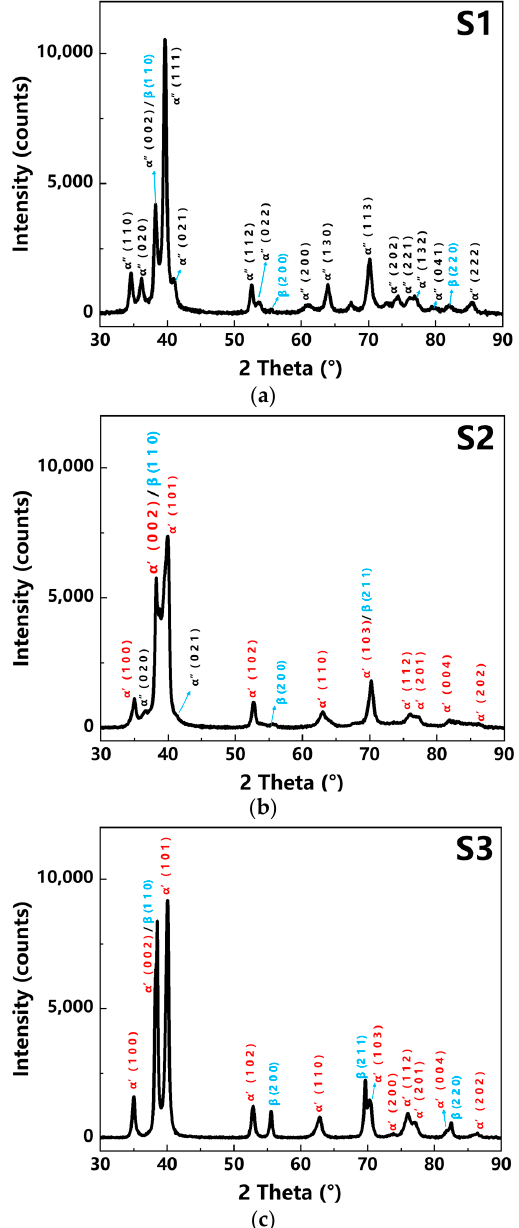
Figure 8. XRD pattern of LPBF Ti ‐ Ta for different volume energy density conditions. ( a ) S1 (v = 120 mm/s, E = 694 J/mm 3 ), ( b ) S2 (v = 220 mm/s, E = 381 J/mm 3 ); and ( c ) S3 (v = 1100 mm/s, E = 76 J/mm 3 ). According to XRD data of S1, S2, and S3, the grain size of Ti ‐ Ta alloy was calculated by the Debye ‐ Scherrer formula,